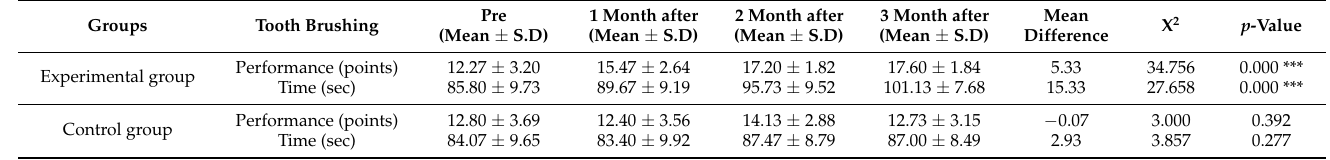
Table 3. The results of tooth-brushing performance and time within a group.